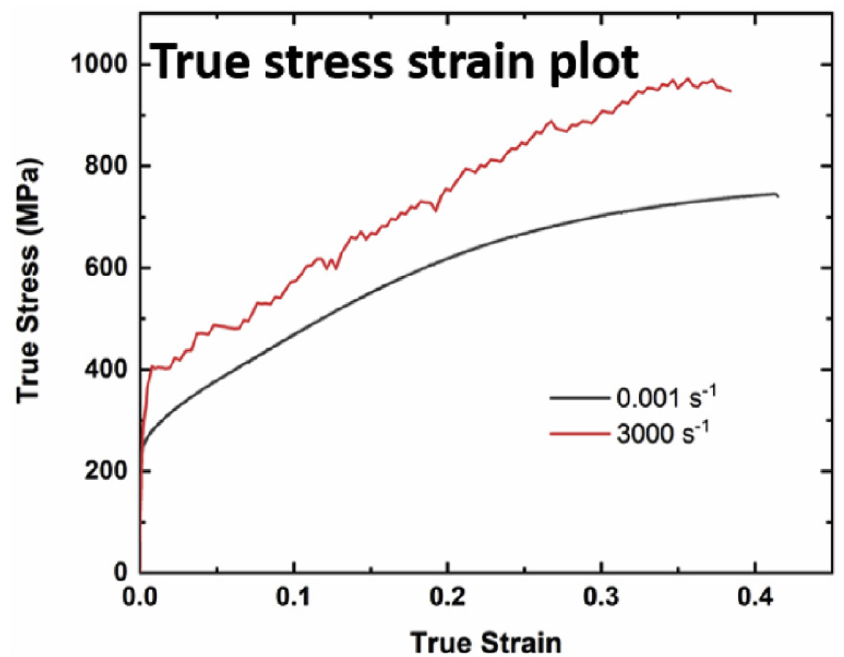
Figure 44. The true stress vs. true strain for the CoCuFeMnNi HEA compression tested at strain rates of 10 − 3 s − 1 and 3 × 10 3 s − 1 (reproduced from Reference [300] with permission).